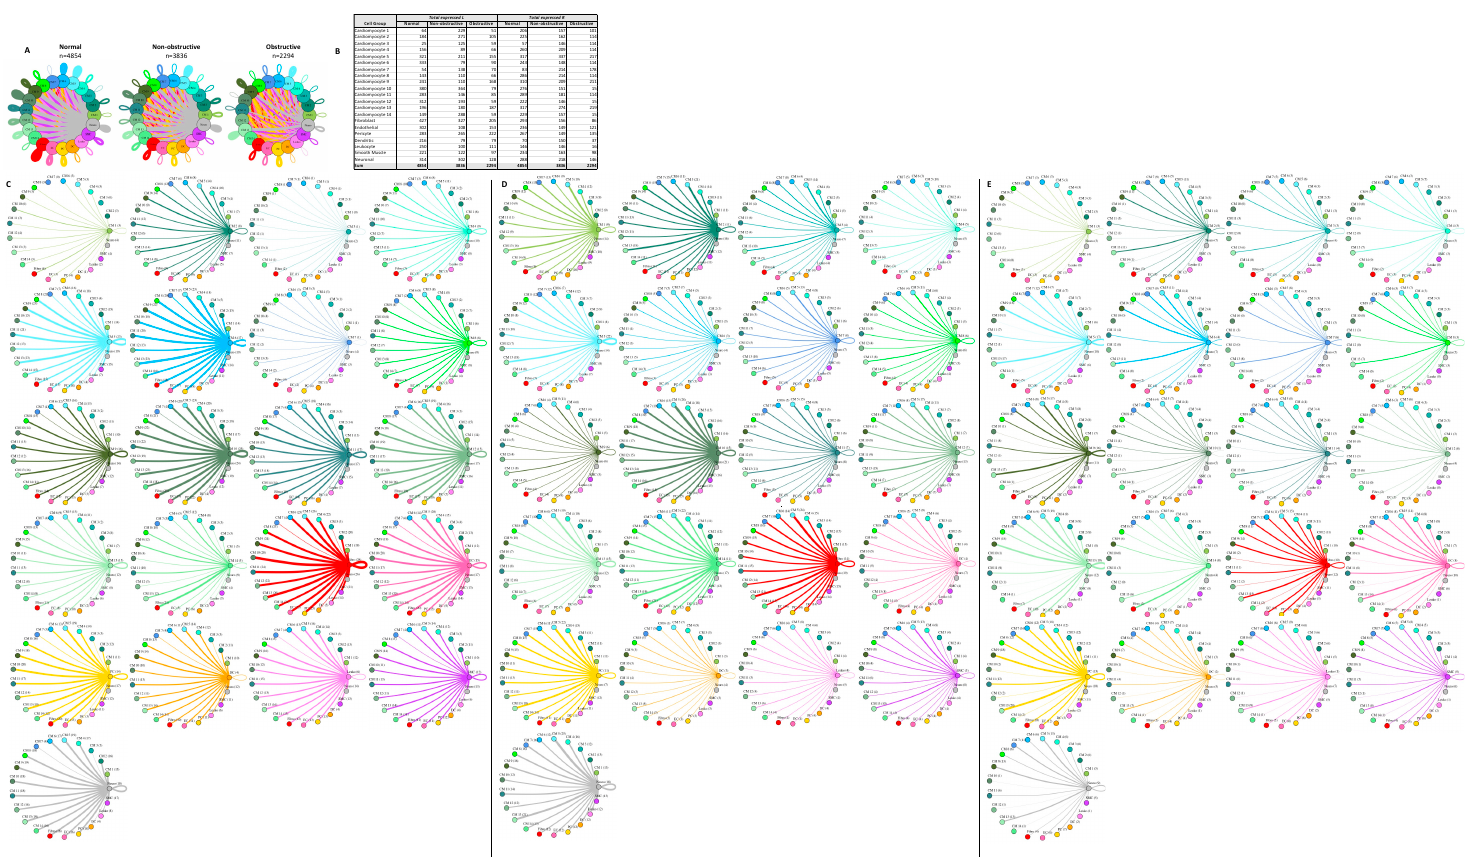
Figure 8. Cell–cell communication networks between cardiomyocyte subtypes and other heart cells in normal control, nonobstructive HCM, and obstructive HCM conditions. ( A ) Comparison of normal (left), nonobstructive HCM (middle), and obstructive HCM (right) communication networks. Line color indicates ligand broadcast by the cell population with the same color. Lines connect to cell types that expressed cognate receptors. Line thickness is proportional to the number of uniquely expressed ligand–receptor pairs. Loops indicate communication within a cell type. ( B ) Quantity of ligands and receptors in expressed ligand–receptor pairs described by cell type and condition (normal, nonobstructive HCM, or obstructive HCM). ( C – E ) Cell–cell communication networks broken down by cell type and cardiomyocyte cluster in normal control ( C ), nonobstructive HCM ( D ), and obstructive HCM ( E ) conditions. Figure formatting follows panel A. Numbers indicate the quantity of uniquely expressed ligand–receptor pairs between the broadcasting cell type (expressing ligand) and receiving cell type (expressing receptor).